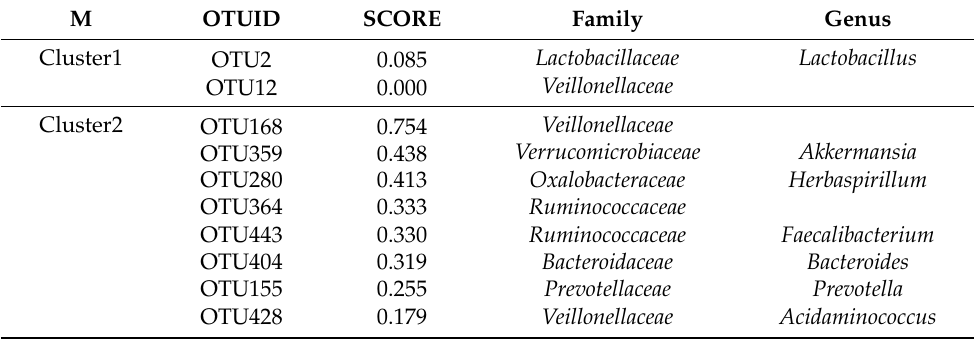
Table A6. The score value and core flora of GMPR+Spectrum in M.